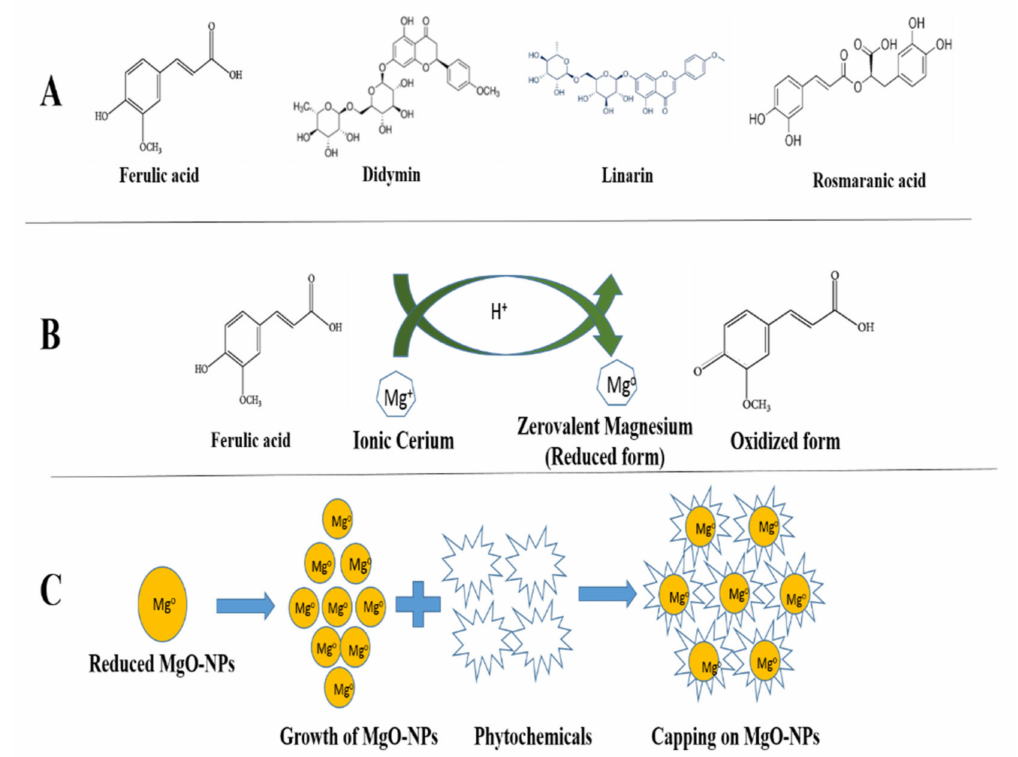
Figure 1. Mechanistic approach for synthesis of MgO-NPs using aqueous extract of Mentha arvensis. ( A ) The structural and chemical formulas of Ferulic acid, Didymin, Linarin, Rosmaranic acid these all compounds are present in Mentha arvensis extract. ( B ) Ferulic acid interacts with magnesium ion and reduced it to Mg +1 to Mg 0 . ( C ) Reduced form of magnesium nanoparticles and phytochemicals that are taking part in in capping o magnesium